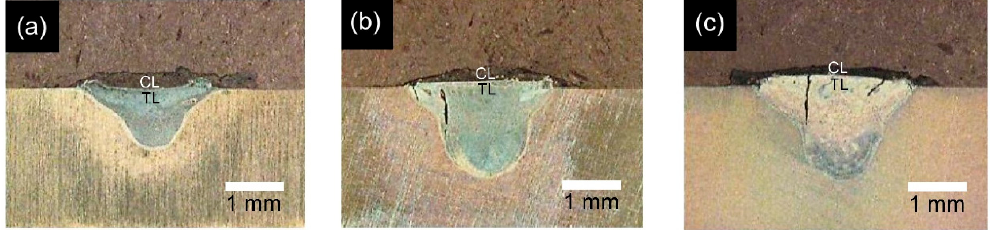
Figure 4. Optical microscope images of weld beads in fluorapatite (FA)/ZrO 2 laser-clad specimens: ( a ) 400 W, 200 mm/min; ( b ) 800 W, 400 mm/min; and ( c ) 1200 W, 600 mm/min. (Note: CL denotes coating layer and TL denotes transition layer).